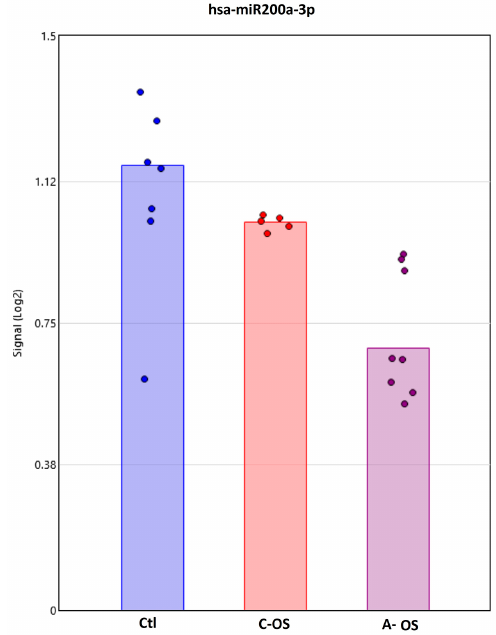
Figure 5. Individual changes in expression of exosomal miRNAs predicted to target Keap1 . Bar plots depict the Affymetrix signal of hsa-miR200a-3p in NPCE cells-derived exosome following C-OS or A-OS. Each group contains a minimum of five independent replicates. One-way ANOVA was performed to identify the p < 0.001 among these three